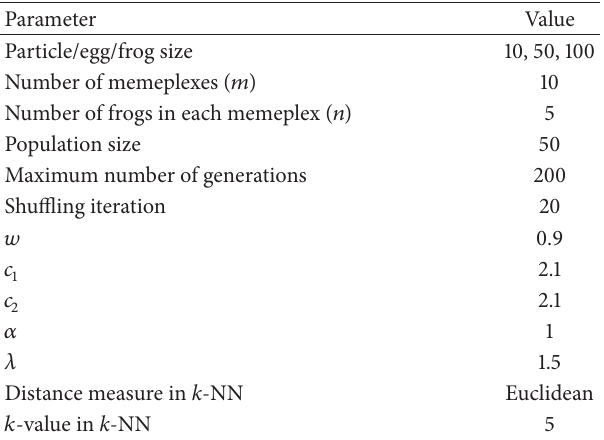
Table 2: Parameters and their